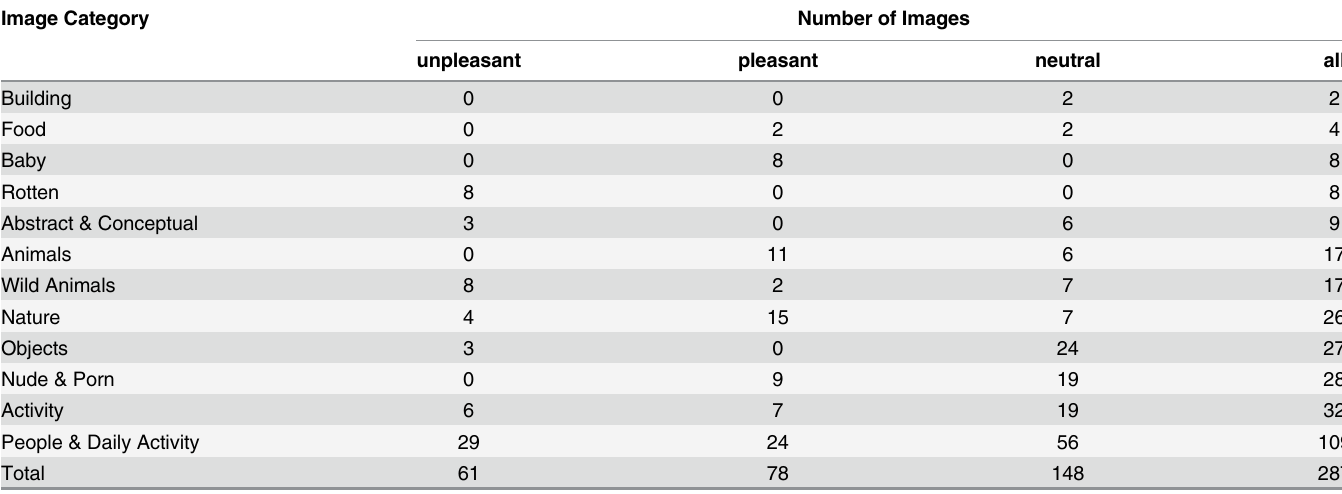
Table 1. Emotional images and their visual